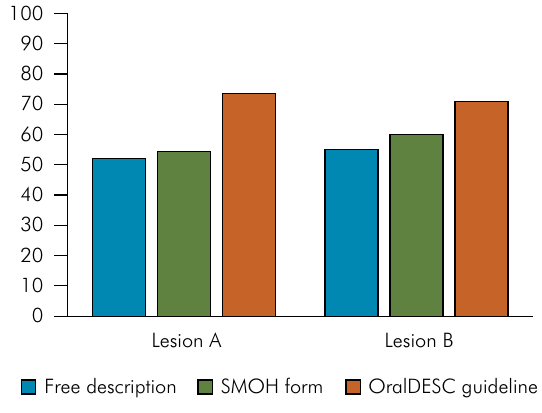
Figure 3. Comparison between average agreement for lesions A and